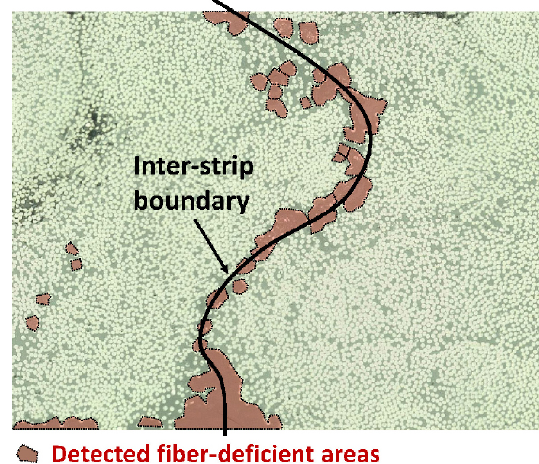
Fig. 26 Adjoining fiber-deficient areas along an inter-strip